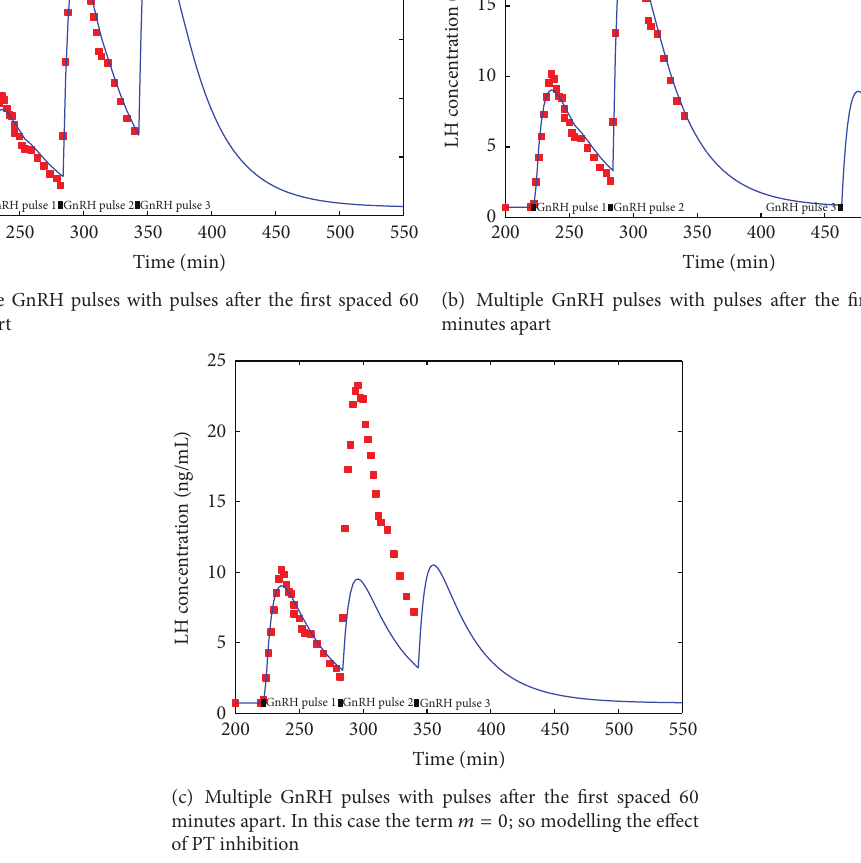
Figure 5: Multiple GnRH pulses simulation using the optimal parameters of Figure 3(b); also, the experimental data for the first two pulses (dotted lines) is